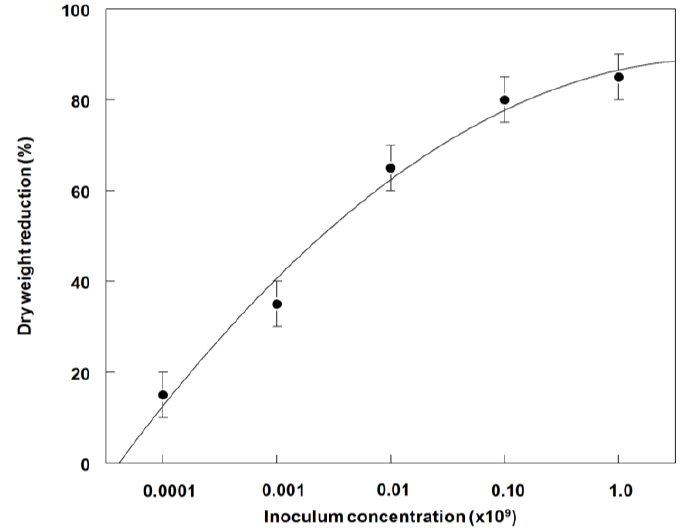
Figure 10. Effect of P. commelinicola inoculum concentration on the dry weight reduction of C. diffusa in the cotyledonary to third leaf growth stage under field conditions. Y = −22.0 + 37.8 X − 3.2 X 2 , R 2 =